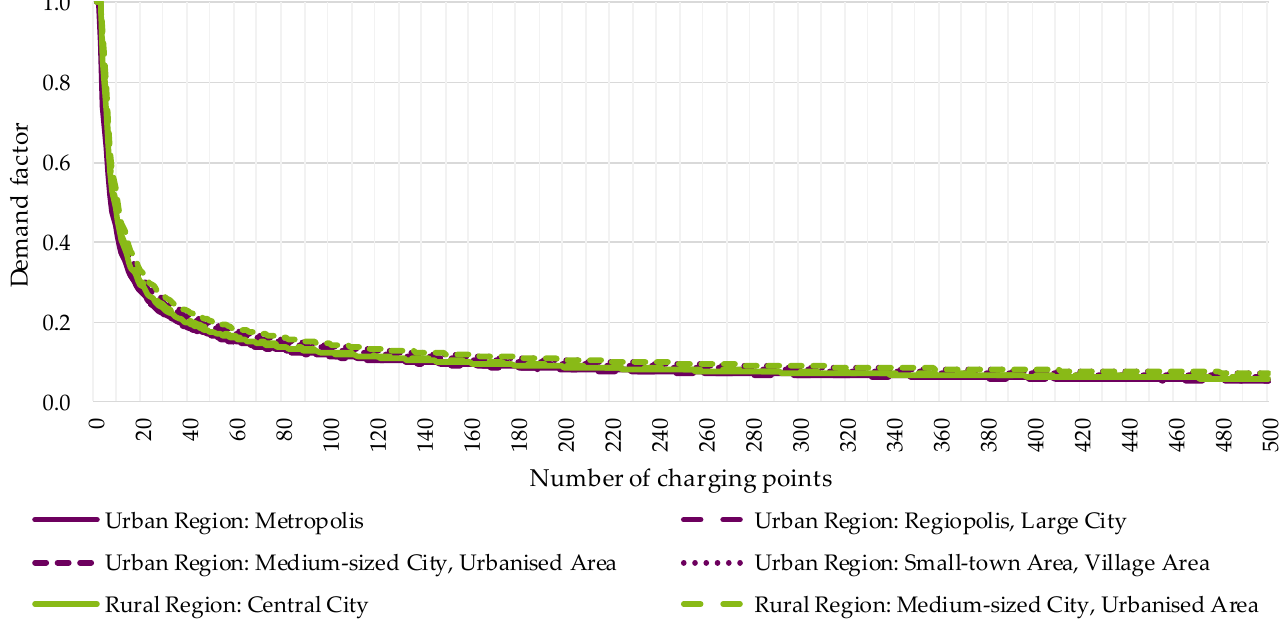
Figure 21. Demand factors (ordinate) for 22 kW charging power and seven different area types.